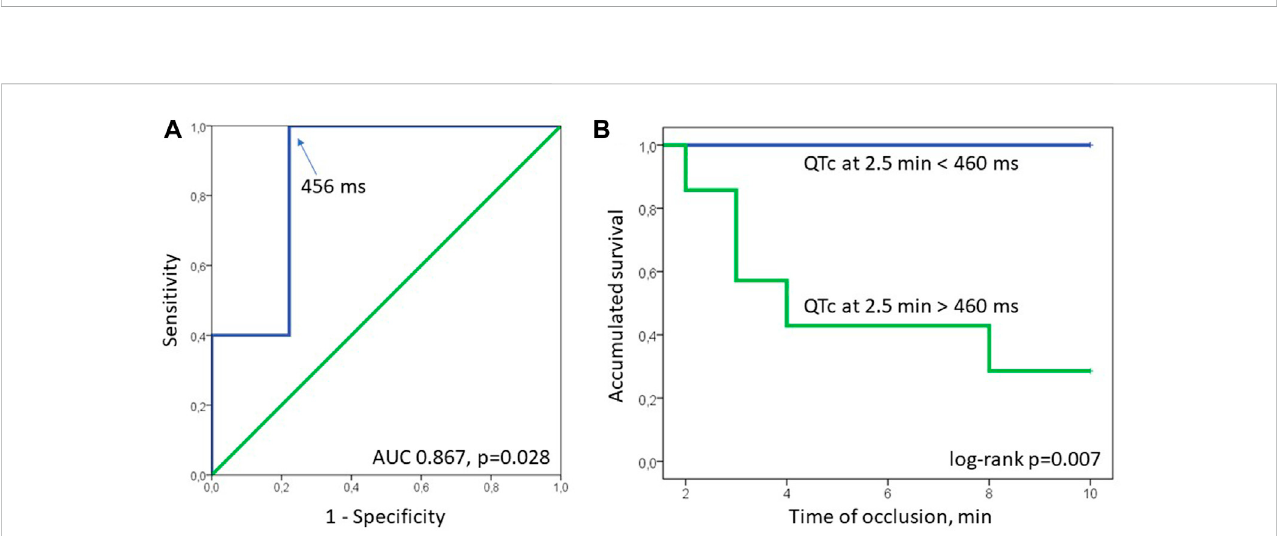
FIGURE 5 ROC curve (panel (A) ) and Kaplan-Meier survival (panel (B) ) analyses. In ROC curve analysis QTc at 2.5 min was associated with phase 1A VF (AUC 0.867, p =0.028)withtheoptimalcut-off > 456 ms(arrow,sensitivity1.00,speci fi city0.778).InKaplan-Meiersurvivalanalysis,phase1AVFincidencewassigni fi cantly different (log-rank p = 0.007) in pigs having maximal QTc at 2.5 min more and less than 460 ms,